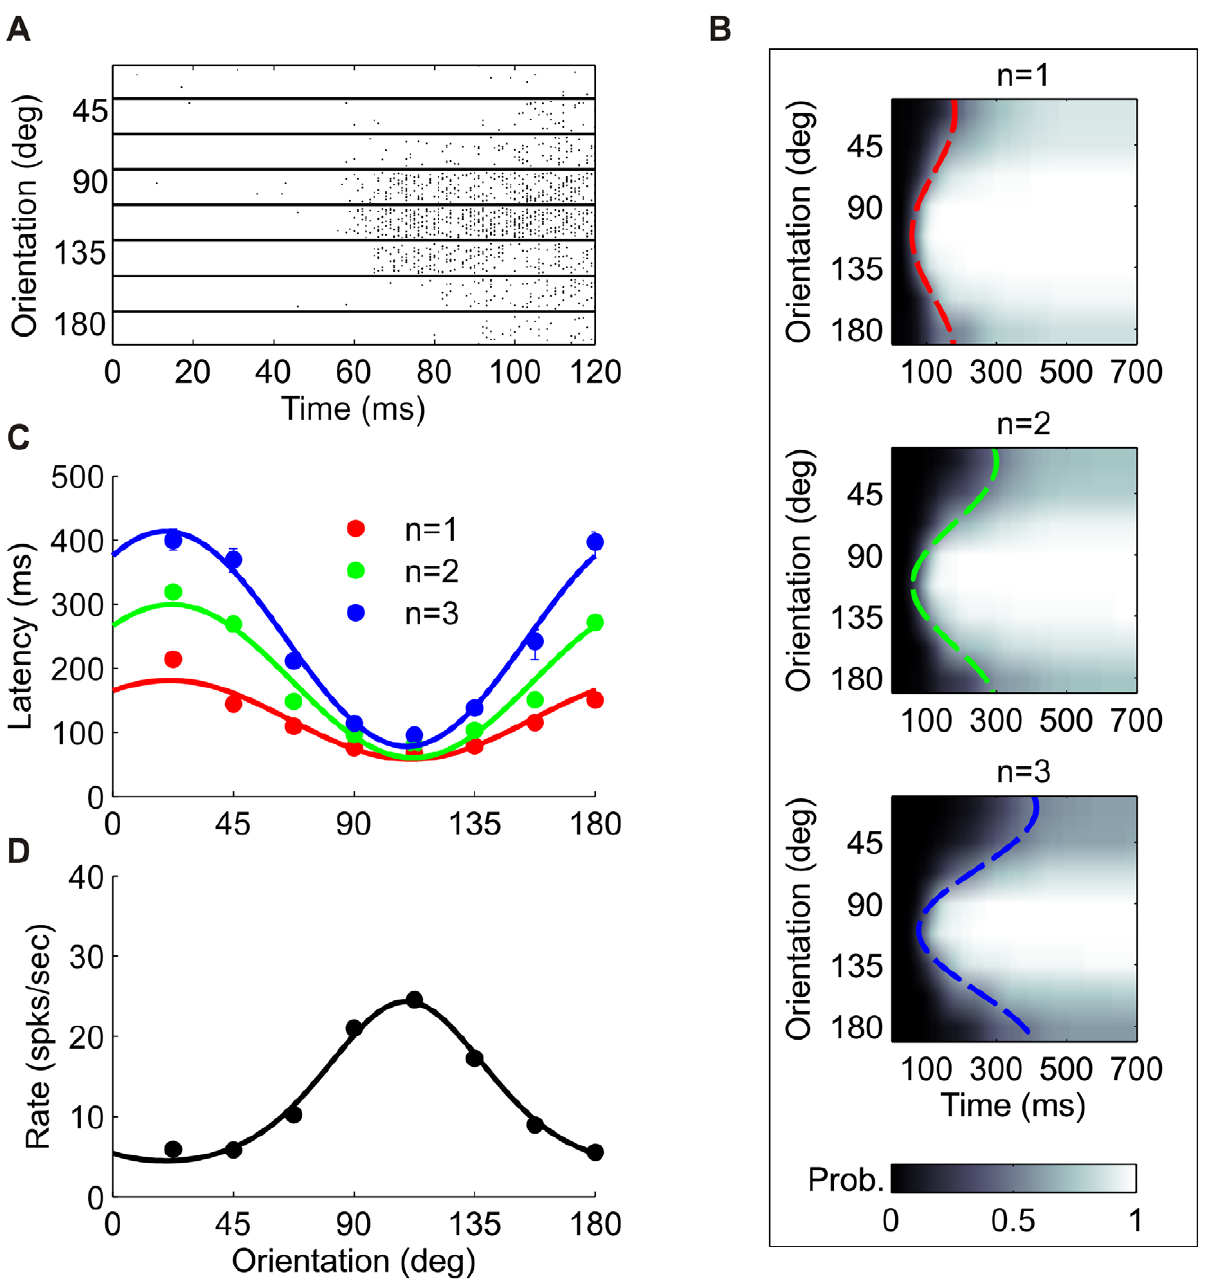
Figure 1. Orientation tuning of spike latencies. (A) Raster plot for of a sample cell in the data (taken from dataset 1 in Table 1). For each orientation, 100 randomly chosen trials (out of 400) are shown. For clarity, only the first 120 ms after stimulus onset are shown. Stimulus duration was 400 ms. (B) Cumulative distribution functions of first, second and third spike latencies ( n denotes the spike number) for the same neuron. Each row corresponds to a different stimulus orientation and the gray levels represent the probability of the spike occurring before the time indicated on the abscissa. (C) Tuning curves of first, second and third spike latencies, computed as level curves of the corresponding cumulative distributions at 0.5. Cosine fits are shown as solid lines and are also shown as dashed lines in (A). (Error bars were calculated according to the method described in Materials and Methods, but are often smaller than the marker size). (D) Rate tuning curve for the same cell over the entire stimulus duration (black circles) and a fitted von-Mises function (solid line). (Error bars were calculated using the standard error of the mean, but are smaller than the marker size).